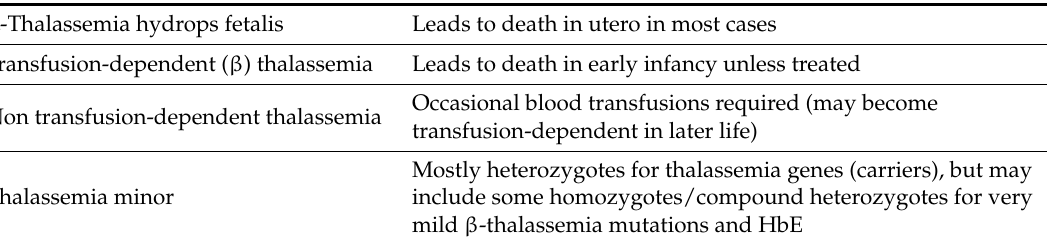
Table 1. Thalassemia groupings according to clinical